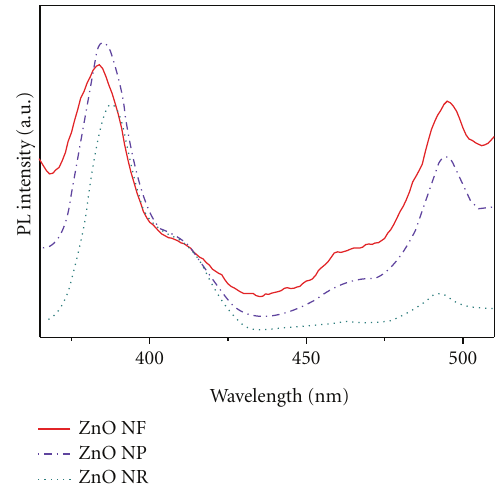
Figure 4: Room temperature PL spectra of ZnO nanoparticles, nanoflowers, and nanorods morphology.